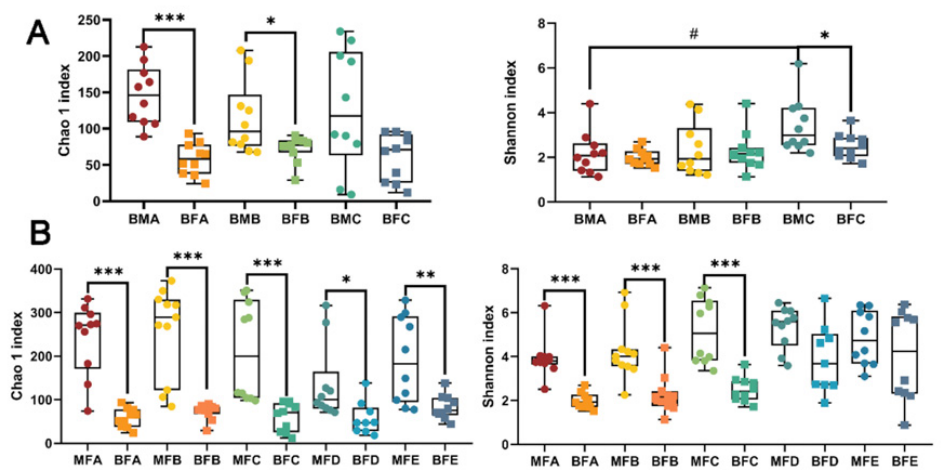
Figure 1. Alpha-diversity illustrating richness and diversity in microbiota of human breast milk and infant feces ( A ), maternal and infant feces ( B ). *, p < 0.05; ** p < 0.01, *** p < 0.001; # p < 0.05. BMA: breast milk (corresponding to infant younger than one month of age), BMB: breast milk (corresponding to infant between 1 and three months of age), BMC: breast milk (corresponding to infant between three and six months of age), MFA: maternal feces (corresponding to infant younger than one month of age), MFB: maternal feces (corresponding to infant between 1 and three months of age), MFC: maternal feces (corresponding to infant between three and six months of age), MFD: maternal feces (corresponding to infant between six and 12 months of age), MFE: maternal feces (corresponding to infant older than 12 months of age), BFA: infant feces younger than one month of age, BFB: infant feces between 1 and three months of age, BFC: infant feces between three and six months of age, BFD: infant feces between six and 12 months of age, BFE: infant feces older than 12 months of